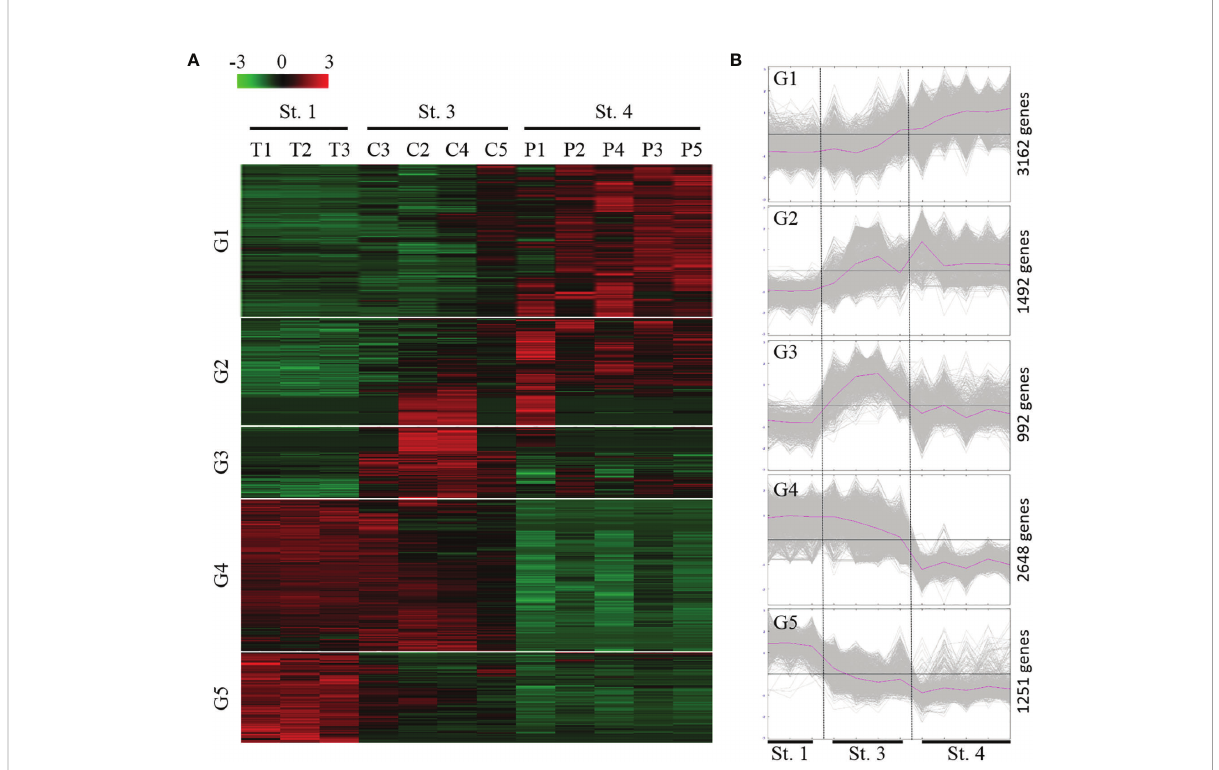
FIGURE 4 Expression pro fi les of the DEGs during the ANG growth. (A) Heatmap for cluster analysis of the differentially expressed genes (DEGs) by hierarchical clustering of Pearson correlation with the Trimmed Means of M values. Green and red indicate downregulated and upregulated genes, respectively. (B) MeV cluster analysis of DEGs from the expression pro fi les during the ANG growth. according to the temporal gene expression across three ANG stages (stage 1, stage 3, and stage 4); these DEGs were divided into fi ve groups. St, stage; G,